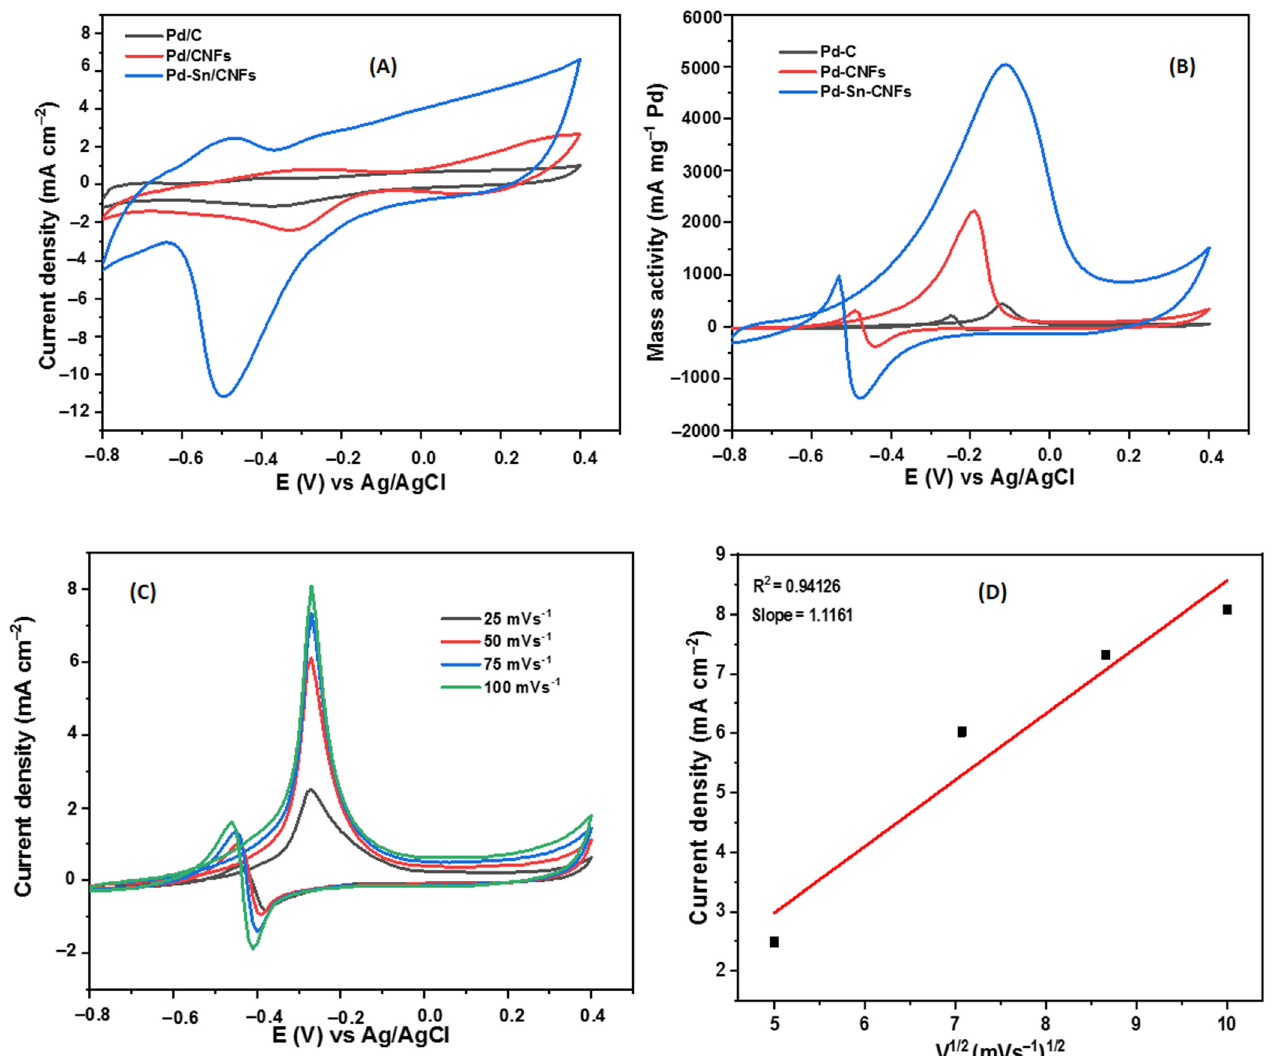
Figure 8. ( A – D ) CV curve of Pd/C, Pd/CNFs and Pd-Sn/CNFs in 1 M KOH ( A ), in 1 M KOH + 1 M CH 3 OH ( B ) solution at a scan rate of 50 mVs − 1 at ambient temperature. CV curve of Pd-Sn/CNFs electro-catalyst in 1 M KOH + 1 M CH 3 OH at various scan rates ( C ) and the relationship between peak current density and scan rates squared ( D ).